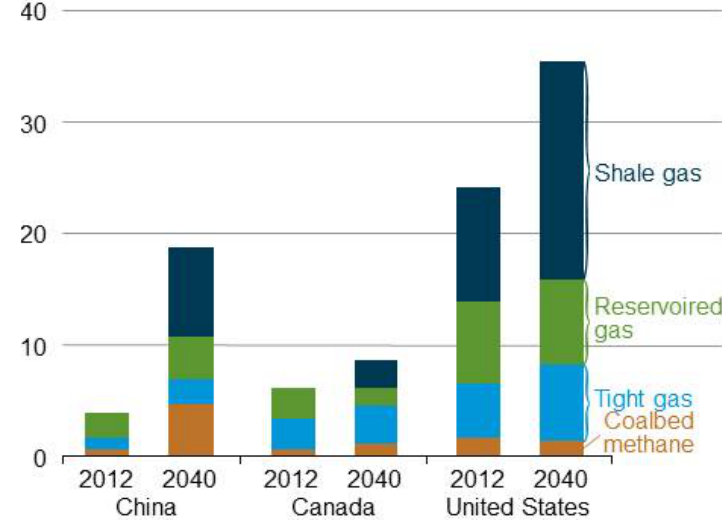
Figure 1. Production of natural gas by type in the United States, China, and Canada: comparison between 2012 and 2040 (trillion cubic feet) [56].